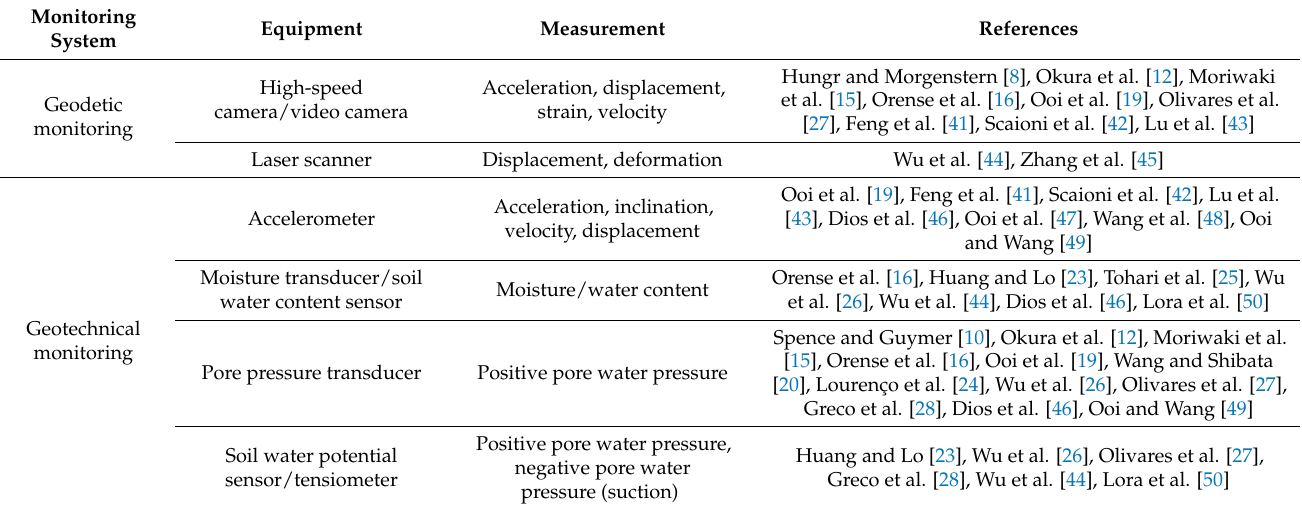
Table 3. Review of the monitoring equipment for small-scale